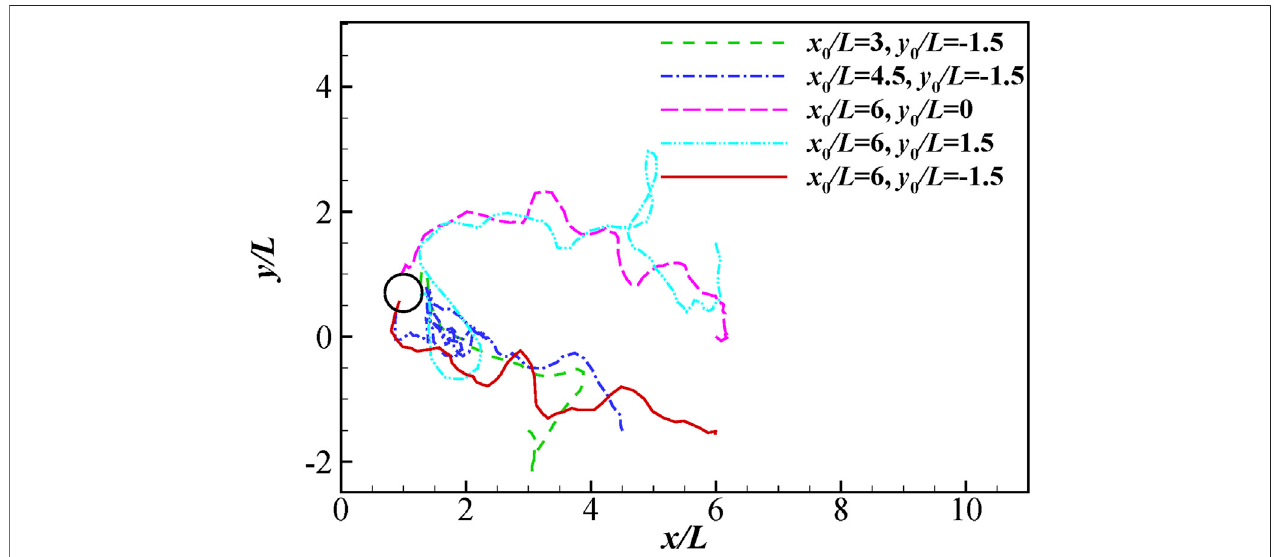
FIGURE 6 | The traces of the head for different initial positions.